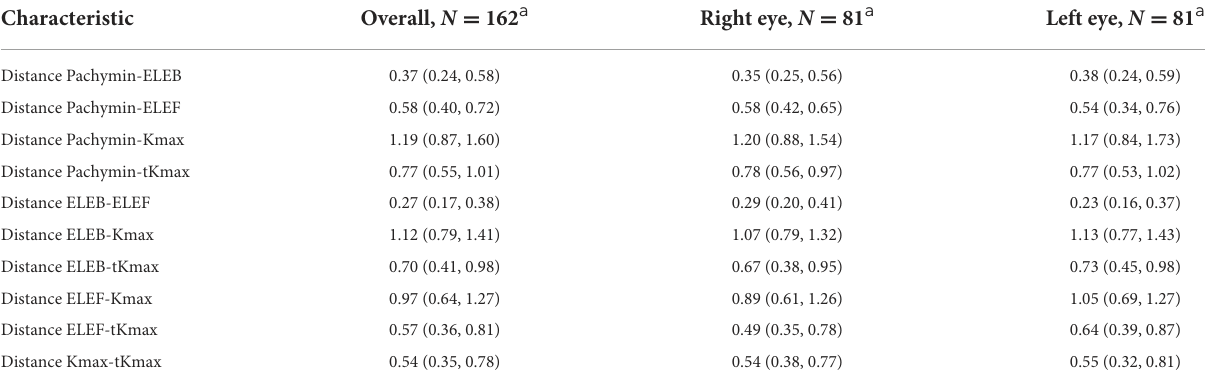
TABLE 2 Distances between locations of different tomographic